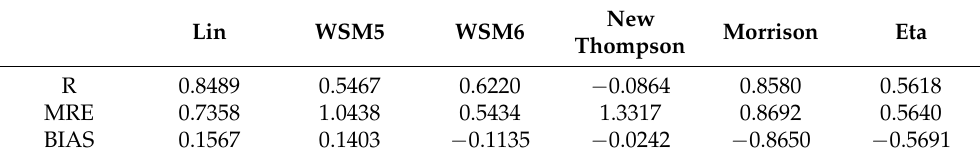
Table 1. Cumulative spatial precipitation error index of six microphysical schemes.